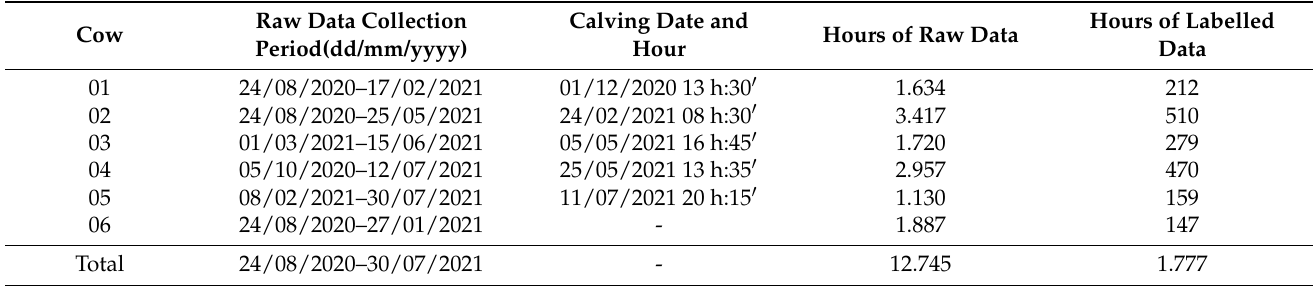
Table 2. Cow-wise distribution of the data.